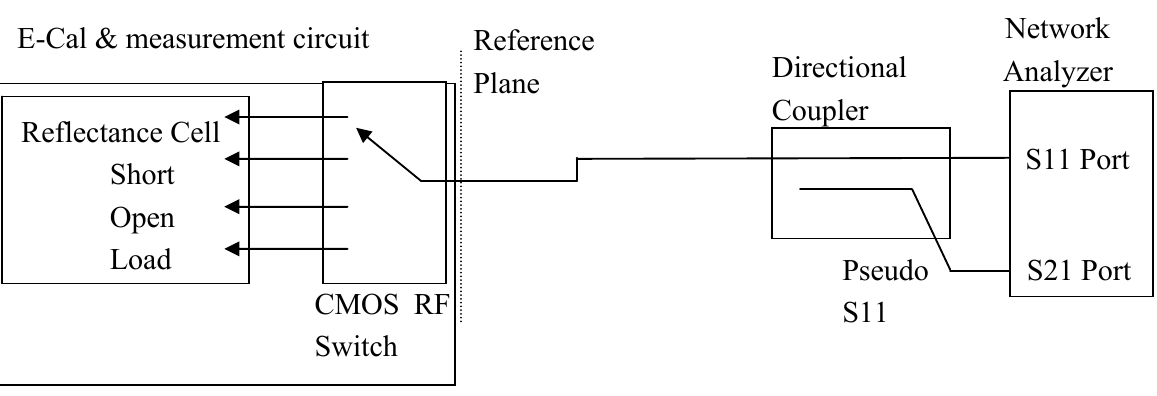
Figure 5. Shown is the testing configuration that was used to measure the performance of the proposed auto-calibration circuit.